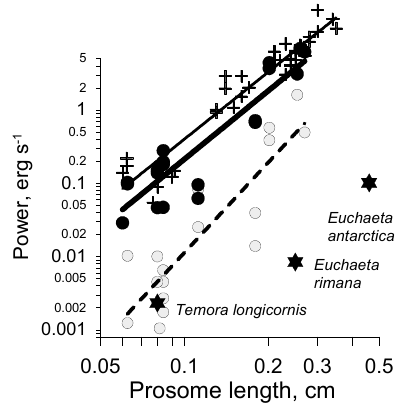
Figure 16. Calculated power versus prosome length required for free cruise-swimming copepods to overcome body drag ( ○ , thin dotted line, N d = 137.7 L 4.09 ) and to move cephalic limbs ( ● , solid line, N p = 266.07 L 3.1 ), as well as the results for attached individuals (+, thin line, N p,att = 436.57 L 3.04 ). Black asterisks indicate literature data for Temora longicornis [17] ; Euchaeta rimana [26], and Euchaeta Antarctica [27] .